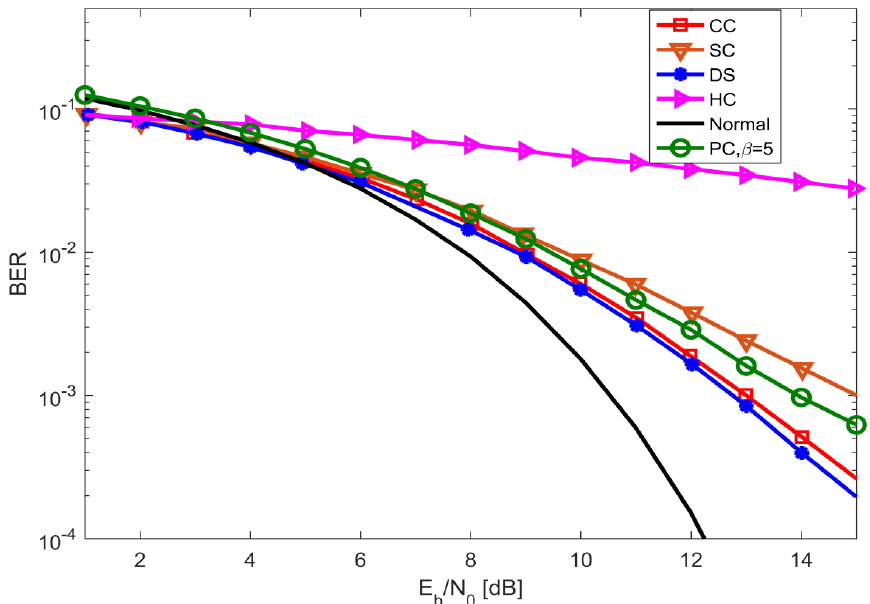
Figure 22. BER performance of PC-OFDM with a High-Power Amplifier (HPA) compared with classical clipping, 16-QAM, Input Back-Off (IBO) = 5 dB, and CR = 10 dB.